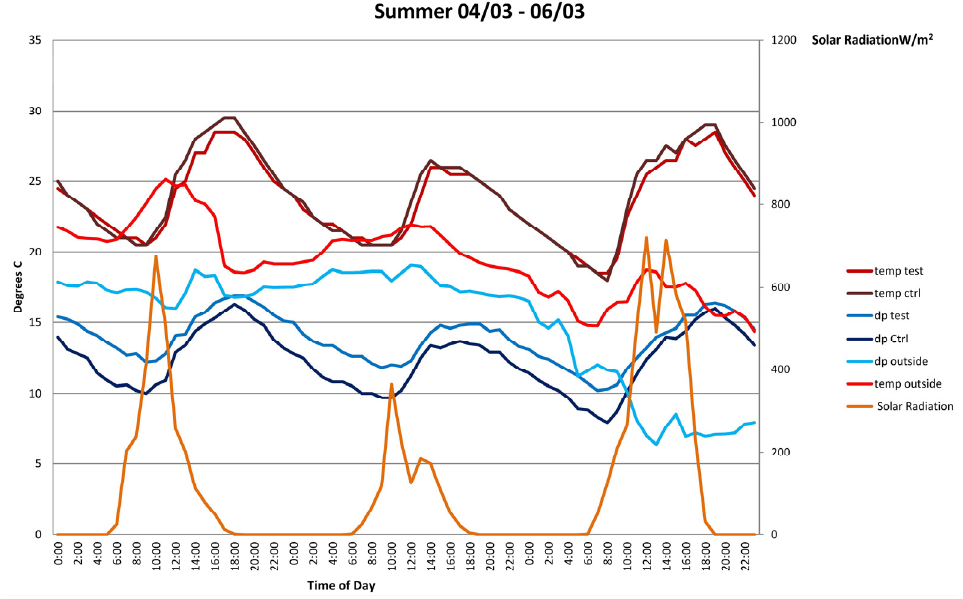
Figure 10. Dry bulb and dew point comparisons for the lounge kitchen dining room with external summer